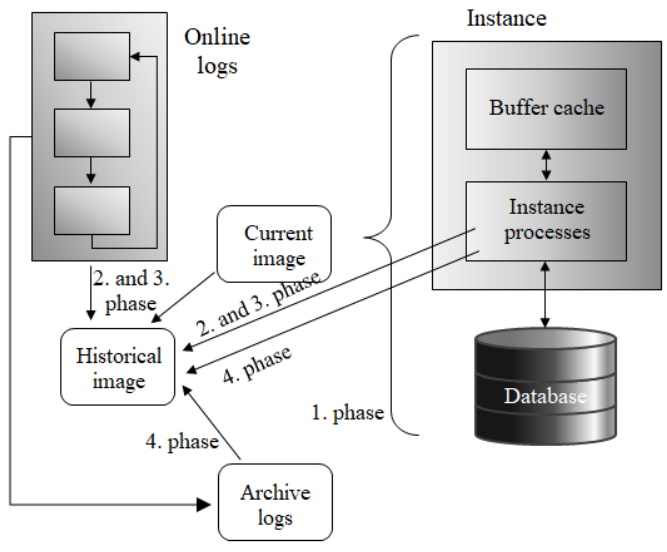
Figure 12. Archive log management.